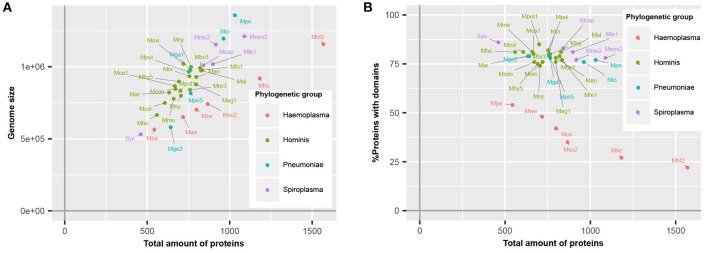
Mycoplasma proteome specification. (A) Correlation between genome size and total amount of proteins. (B) Ratio of proteins covered by protein domains. Mag, M. agalactiae; Mal, M. alligatoris; Man, M. anatis; Mca, M. canis; Mcol, M. columbinum; Mge, M. genitalium; Mio, M. iowae; Mmc, M. mycoides capri; Movi, M. ovipneumoniae; Mpn, M. pneumoniae; Mar, M. arthritidis; Mbo, M. bovis; Mca, M. capricolum subsp. capricolum; Mcon, M. conjunctivae; Mcr, M. crocodyli; Mcy, M. cynos; Mfe, M. fermentans; Mga, M. gallisepticum; Mhc, M. haemocanis; Mhf, M. haemofelis; Mho, M. hominis; Mhy, M. hyopneumoniae; Mhr, M. hyorhinis; Mle, M. leachii; Mmo, M. mobile; Mmm, M. mycoides subsp. mycoides; Mov, M. ovis; Mpa, M. parvum; Mpe, M. penetrans; Mpul, M. pulmonis; Mput, M. putrefaciens; Msu, M. suis; Msy, M. synoviae; Mwe, M. wenyonii; Syn, JCVI-Syn3.0. Numbers relate to strains (Table S4).